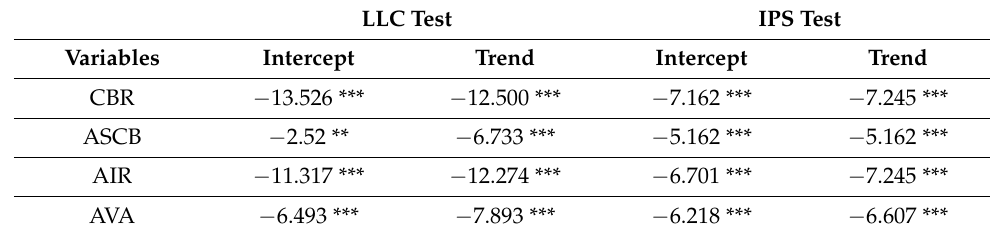
Table 2. Results of panel unit root test at the first difference I